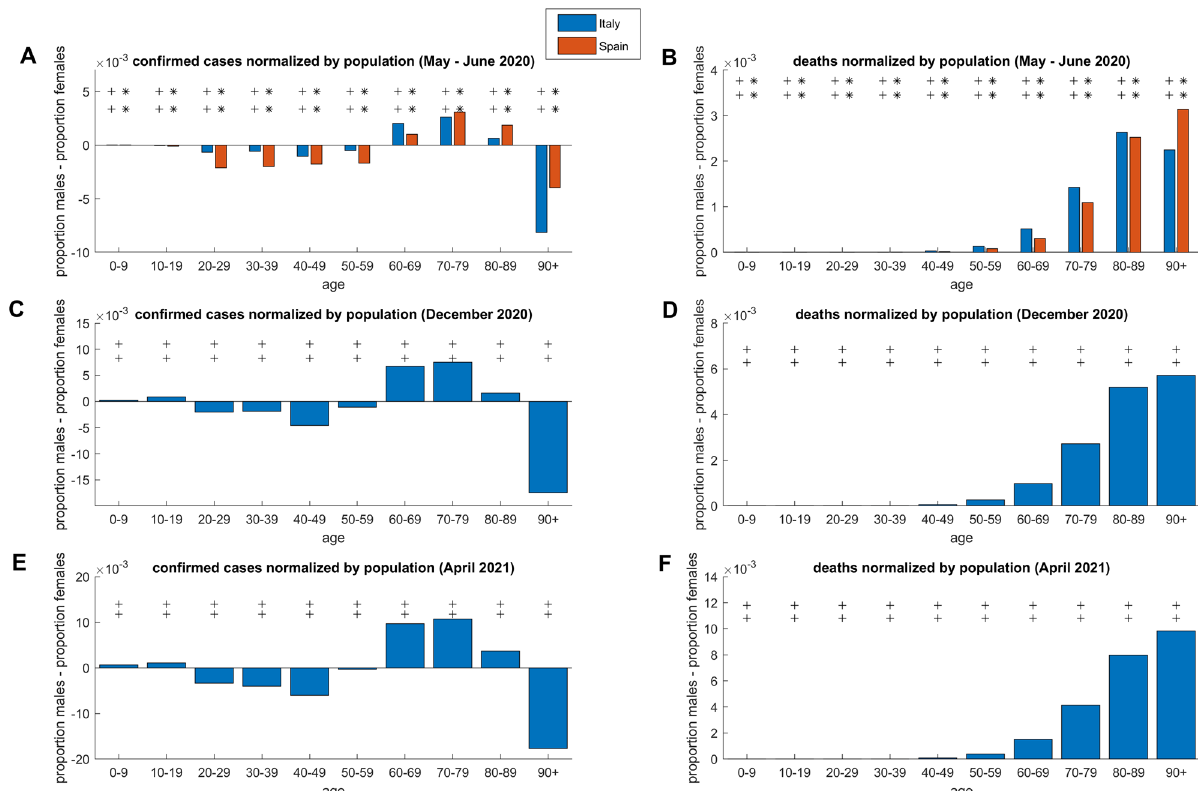
Figure 4. Data comparison of Spain and/or Italy COVID-19 outbreak for population normalized open access variables which are common to both national data sources in different time points from May 2020 to April 2021. (A) Confirmed cases normalized by national population in Spain (May 29, 2020) and Italy (June 3, 2020). (B) Deaths normalized by national population in Spain (May 29, 2020) and Italy (June 3, 2020). (C) Confirmed cases normalized by national population in Italy (December 29, 2020). (D) Deaths normalized by national population in Italy (December 29, 2020). (E) Confirmed cases normalized by national population in Italy (April 14, 2021). (F) Deaths normalized by national population in Italy (April 14, 2021). The presence of at least one symbol (star for Spain and plus for Italy: 1 symbol indicates p-values below 0.05, 2 symbols p-values below 0.001) on top of a specific age strata indicates that the sex inequality is statistically significant. For all panels, the line on zero indicates the threshold over which, for the respective variable, the impact of COVID-19 on males is larger than on